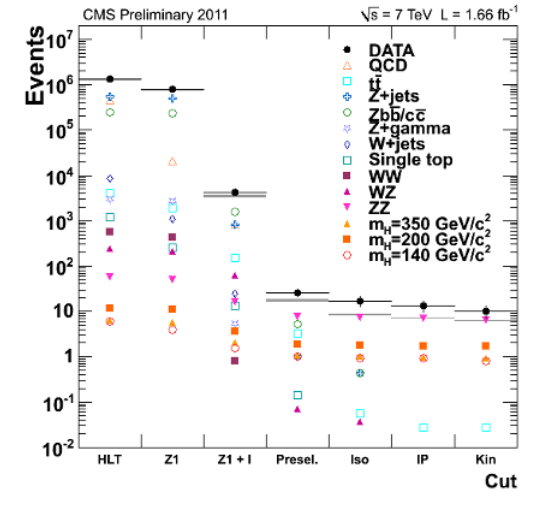
Fig. 1. Event yields in the 4 µ channel as a function of the event selection steps. Black points with uncertainties represent the data, other symbols represent the MC expectations. The samples cor- respond to an integrated luminosity of L = 1 . 66 fb − 1